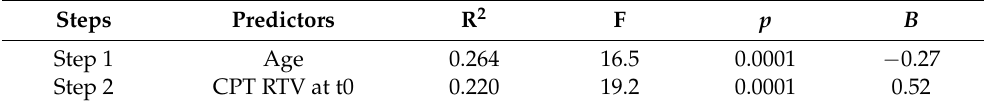
Table 6. Hierarchical linear regression model predicting CPT RTV at t1 after MPH